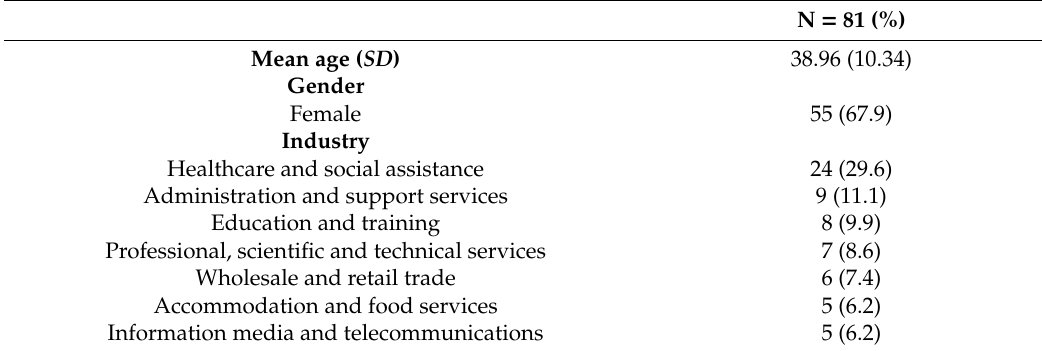
Table 1. Sample Table 1. Sample characteristics.